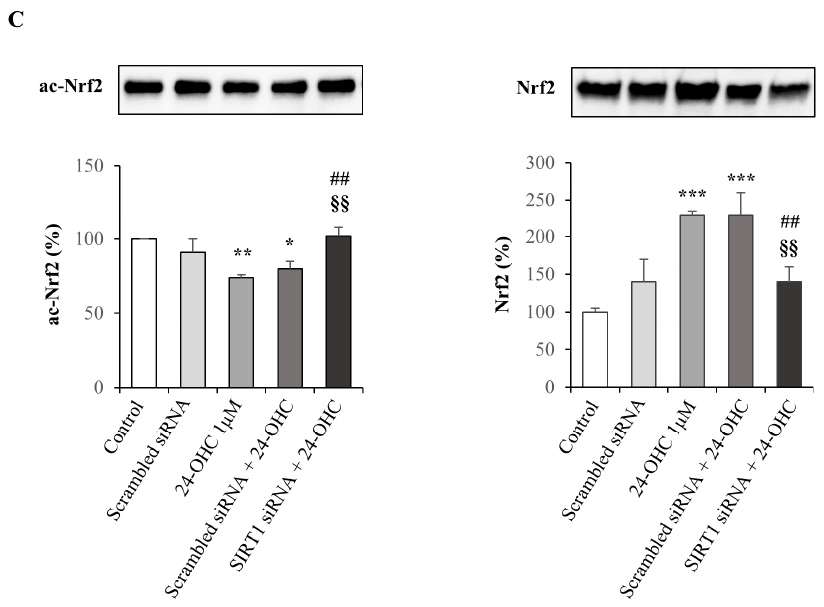
Figure 2. Effect of 24-OHC on Nrf2 expression and on the levels of acetylated and total Nrf2, and SIRT1-dependent Nrf2 acetylation in SK-N-BE cells. ( A ) Nrf2 gene expression was quantified by real-time RT-PCR in cells treated with 24-OHC (1 µ M) up to 6 h. Data, normalized to the corresponding β 2 -microglobulin, are expressed as mean values ± SD of three different experiments. * p < 0.05, ** p < 0.01, **** p < 0.0001 vs. control. ( B ) Acetylated Nrf2 (ac-Nrf2) and total Nrf2 protein levels were analyzed by Western blotting in cells treated with 24-OHC (1 µ M) up to 24 h. Representative blots are shown. The histograms represent mean values ± SD of three experiments. Densitometric measurements are expressed as percentage of control value. * p < 0.05, ** p < 0.01, **** p < 0.0001 vs. control. ( C ) Acetylated Nrf2 (ac-Nrf2) and total Nrf2 protein levels were analyzed in cells transfected for 6 h with SIRT1 or scrambled siRNA and then treated with 24-OHC (1 µ M) for 16 h. Representative blots are shown. The histograms represent mean values ± SD of three experiments. Densitometric measurements are expressed as percentage of control value. * p < 0.05, ** p < 0.01, *** p < 0.001 vs. control; ## p < 0.01 vs. 24-OHC; §§ p < 0.01 vs. scrambled siRNA +